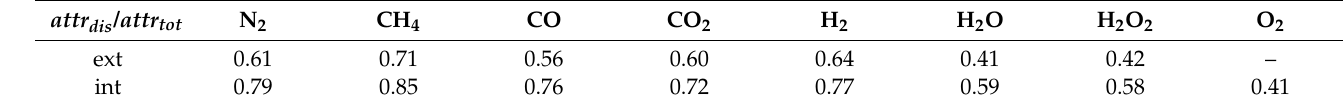
Table 1. The ratio of the dispersion attraction to the total attraction of small molecules adsorbed on [6, 6]CNB.